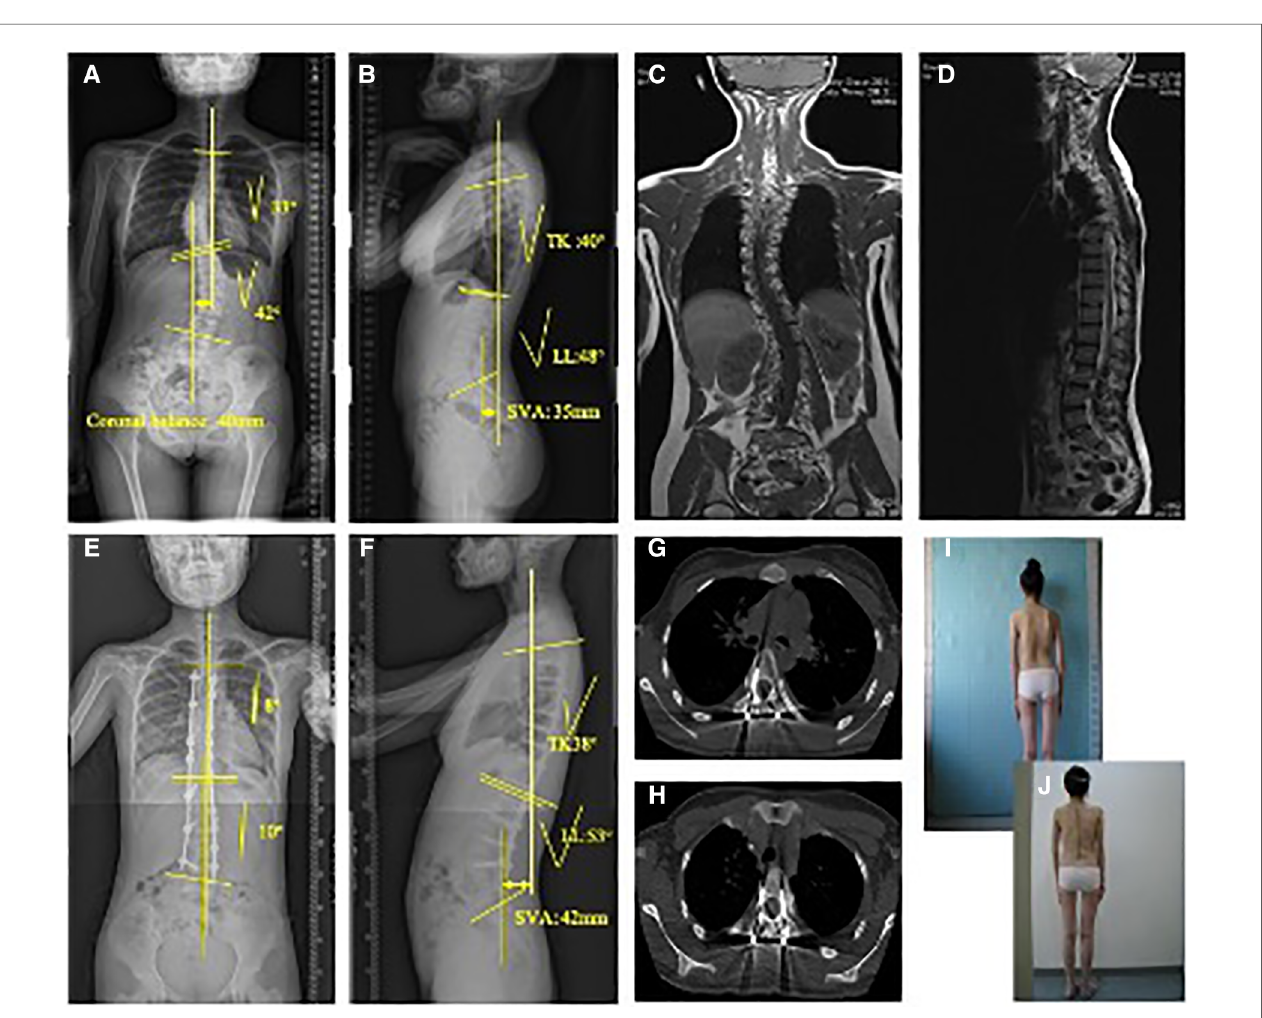
FIGURE 3 This picture showed the clinical pre-operative picture of this scoliosis patient. A 14-year old female Lenke 1 AIS patient underwent robot-assisted scoliosis correction surgery. Preoperative anteroposterior ( A ) and lateral ( B ) full spine X-ray showed a Cobb angle of 42°in major thoracic curve and 33°in secondary lumbar curve (the angle between major curve and secondary curve). Coronal ( C ) and sagittal ( D ) view of full spine MRI showed there was no abnormalities within spinal cord, which supported the diagnose of AIS when combined with other clinical characteristics. Postoperative anteroposterior ( E ) and lateral ( F ) full spine X-ray showed major thoracic curve was corrected to 10°, while secondary curve was corrected to 8°. Postoperative CT scan was used to evaluate the accuracy of screw insertion, and the typical image of satisfactory position ( G ) and lateral cortical perforation ( H ) were shown. In addition, clinical images of the patients both pre-operatively ( I ) and post-operatively ( J ) were also shown in Figure